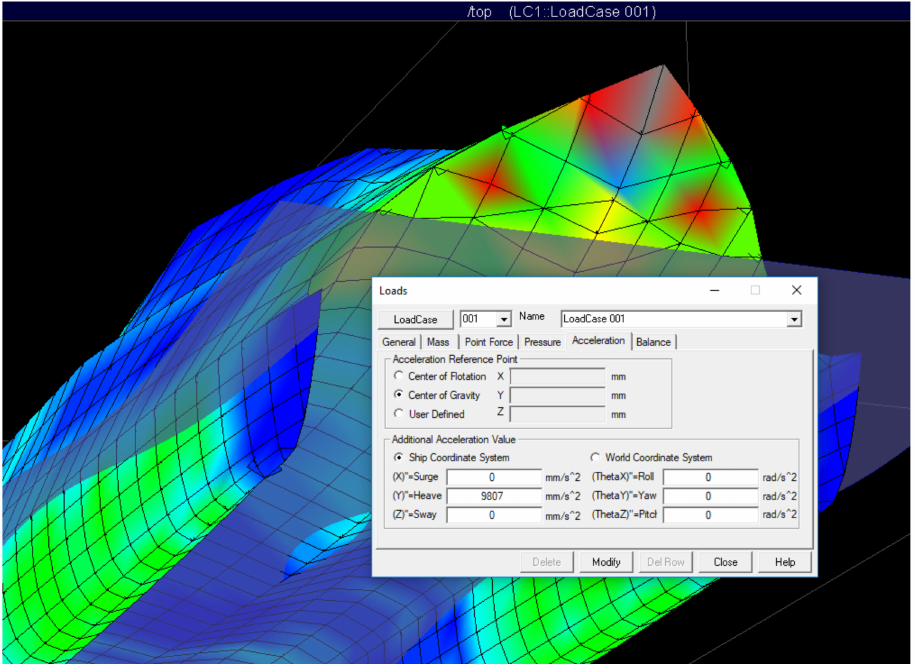
Figure 15. Total of a 1.0 g vertical acceleration applied to FE model and stress results.